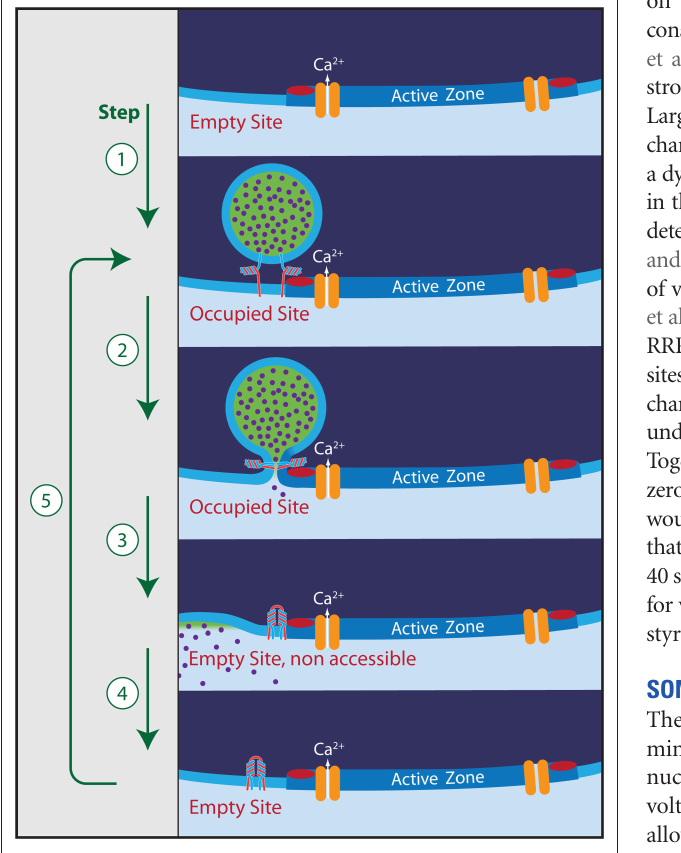
Figure 1 | The release cycle. Five steps can be identified: (1) Docking of a vesicle to an empty release site (red bar). Mean residence time of a vesicle is at least 40 s in the absence of stimulation. (2) Ca 2 + -triggered exocytosis. (3) Removal of the vesicle by full collapse fusion or by kiss-and-run. Some vesicular components may still be bound to the release site, leaving it non-accessible for the docking of a new vesicle. (4) Clearance of the release site by dissociation of remaining interaction partners (must happen within 200 ms during high-frequency stimulation). (5) Docking of a new vesicle (equivalent to step 1). The symbol for the entity blocking the release site in the non-accessible state was chosen to resemble a cis -SNARE complex. Such complexes, in association with Rim, Munc-13, synaptotagmin, and possibly Ca-channels may, indeed, be the postulated blockers. However, this assignment and the relationship of such a complex to endocytosis is clearly a matter of speculation in the framework of this electrophysiology-based